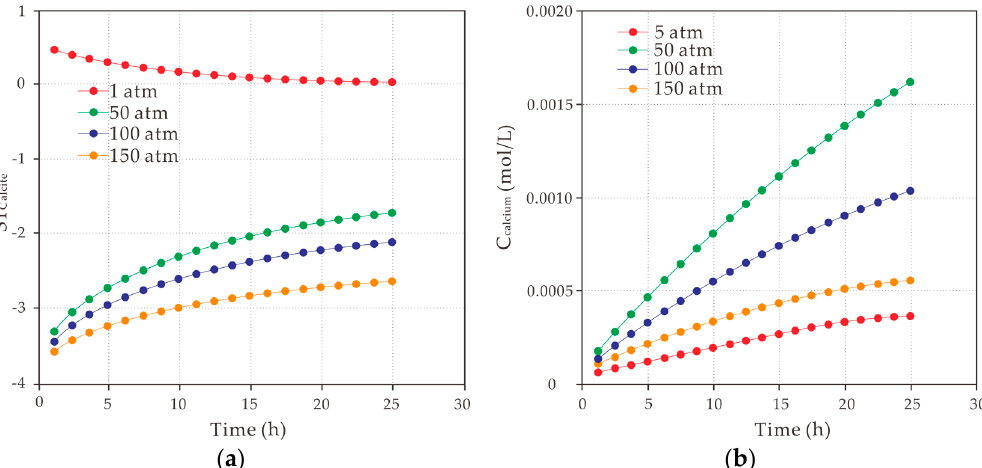
Figure 11. Saturation indexes (SI) for concentrations of calcite and calcium at different pressures: ( a ) SI calcite and ( b ) C calcium .